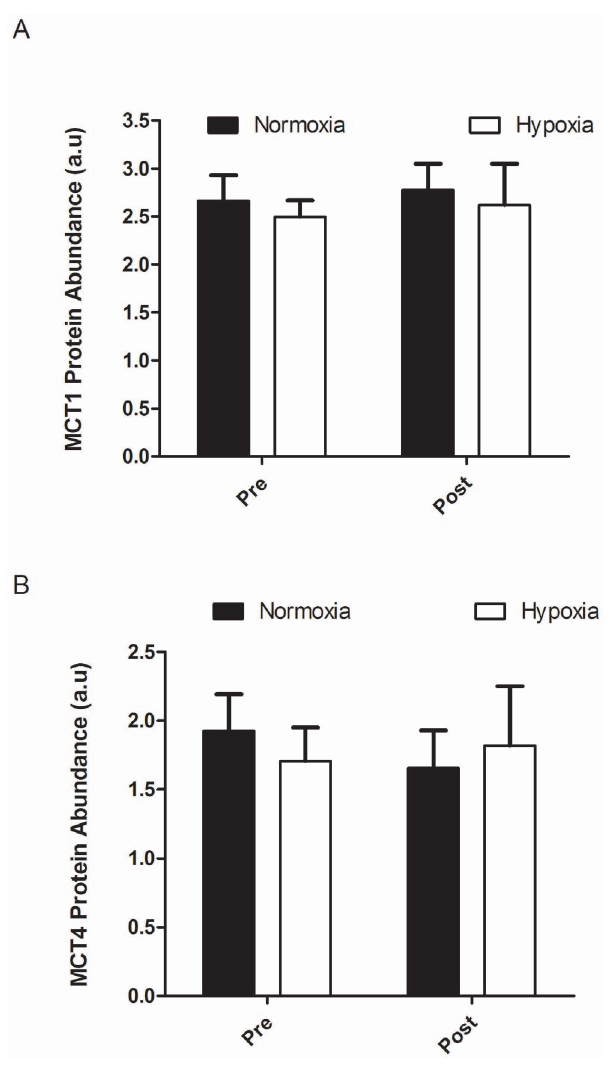
Figure 1. The MCT1 (A) andMCT4 (B) protein content for the normoxic (N; n=8) and hypoxic (H; n=10) groups, pre (W0) and post (W4) the 3 wk IHT period.